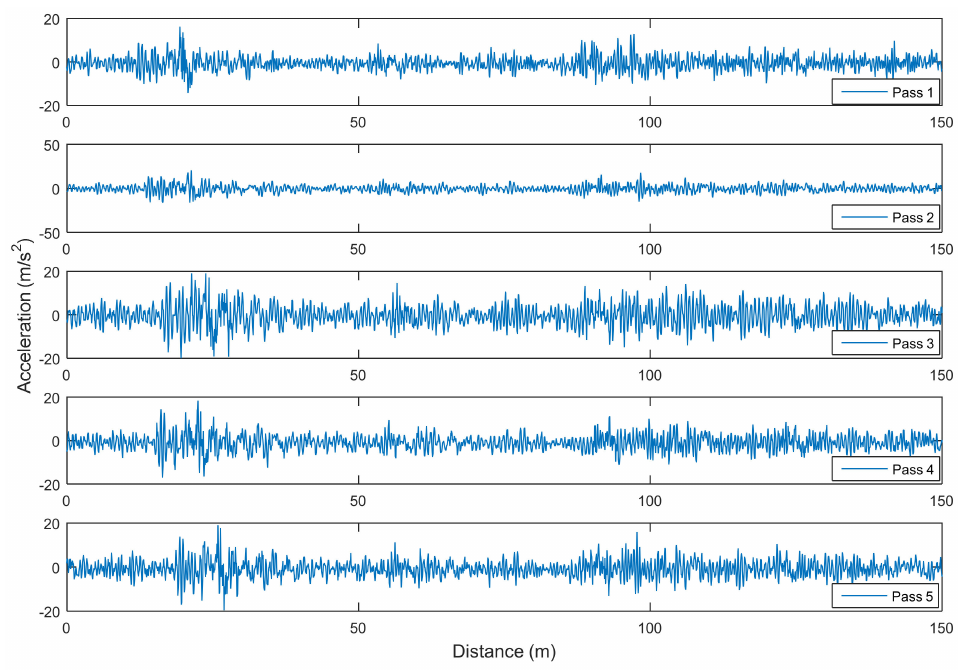
Figure 9. Bogie vertical acceleration